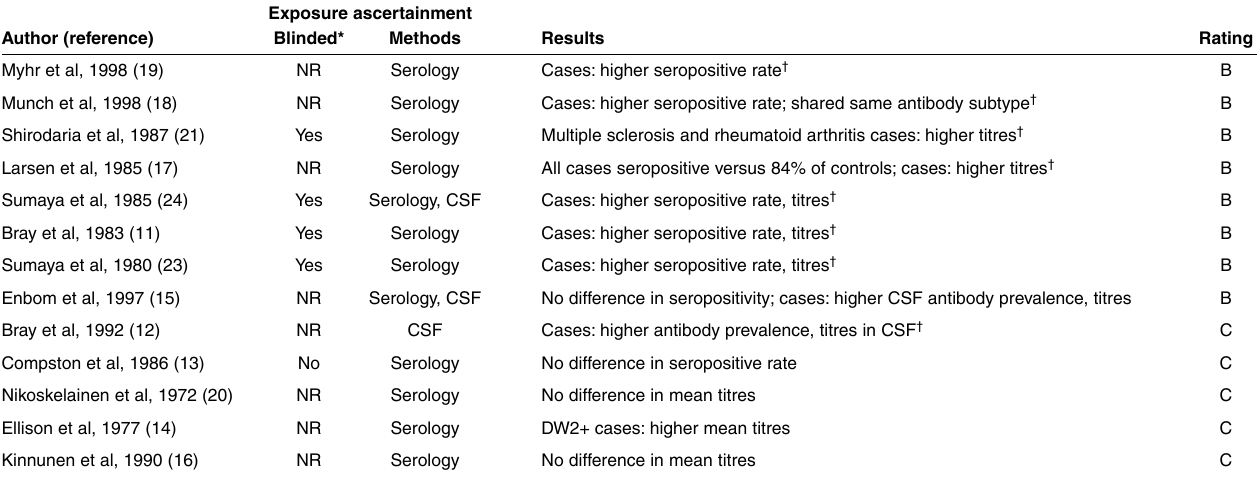
TABLE 2 Seroepidemiological studies – Methods and